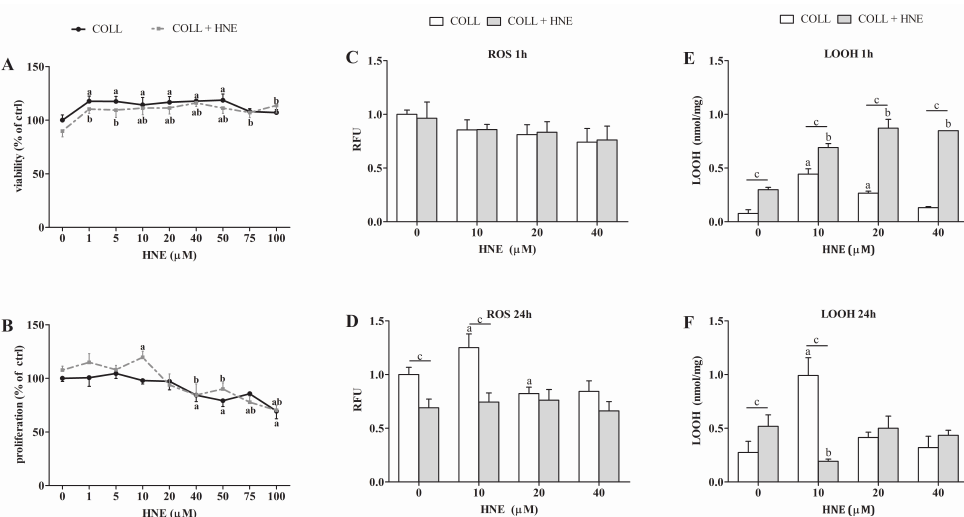
Figure 1. Sensitivity of RbE4 cells on HNE treatment on collagen (COLL) and collagen treated with 10 µ M HNE (COLL + HNE). ( A ) Viability of RbE4 cells assessed by MTT assay after HNE treatment (0, 1, 5, 10, 20, 40, 50, 75, 100 µ M) and represented as % of control. ( B ) Proliferation of RbE4 cells measured by 3H thymidine assay after HNE treatment (0, 1, 5, 10, 20, 40, 50, 75, 100 µ M) and represented as % of control. ROS levels ( C ) 1 h and ( D ) 24 h after HNE treatment (0, 10, 20, 40 µ M) represented in RFU (relative fluorescence unit). LOOH measured 1 h ( E ) and 24 h ( F ) after HNE treatment (0, 10, 20, 40 µ M). All results are represented as mean ± SD, n = 12 samples in each group from 3 independent experiments. a—statistically significant in respect to control (0) on pure collagen, p < 0.001; b—statistically significant in respect to control (0) on modified collagen, p < 0.001; c—statistically significant between groups of same treatment, p <